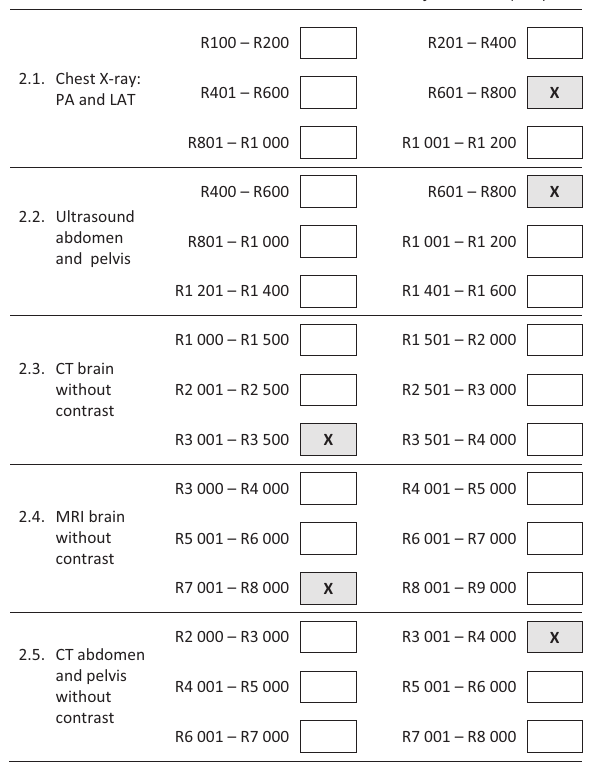
FIGURE 1: Cost estimation component of the questionnaire with radiological costs from which the participants had to select one correct option (the correct options are indicated by X).